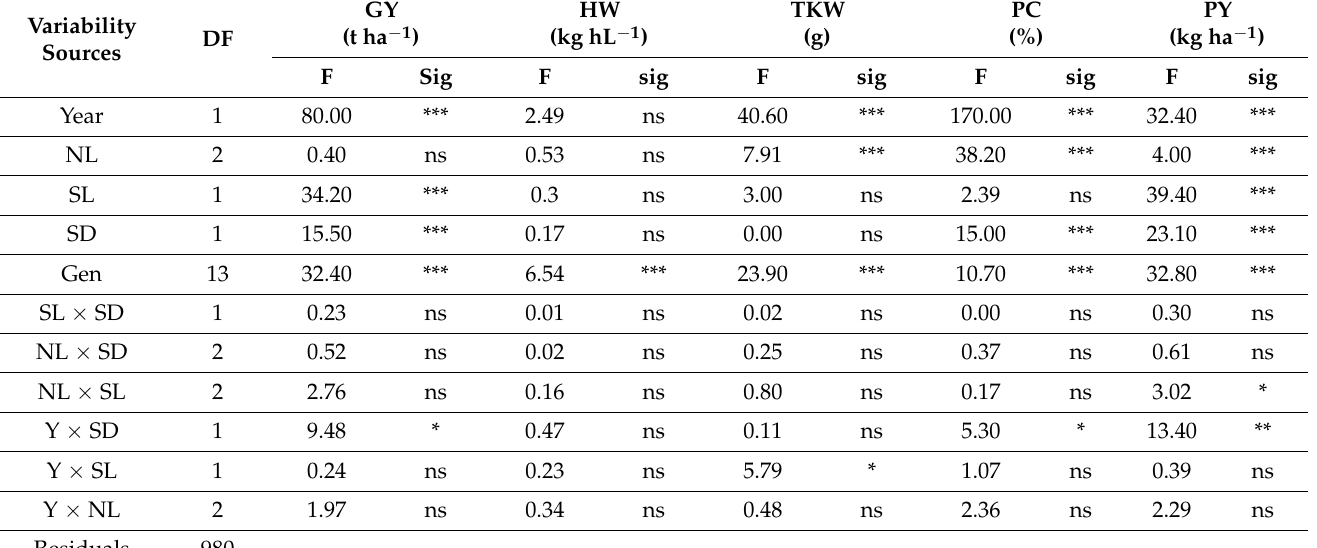
Table 3. Results of the ANOVA for grain yield (GY), hectoliter weight (HW), thousand kernel weight (TKW), protein concentration (PC) and protein yield (PY). The table columns report the Fisher F (F) and the significance levels: * = 0.05, ** = 0.01, *** = 0.001, ns = not